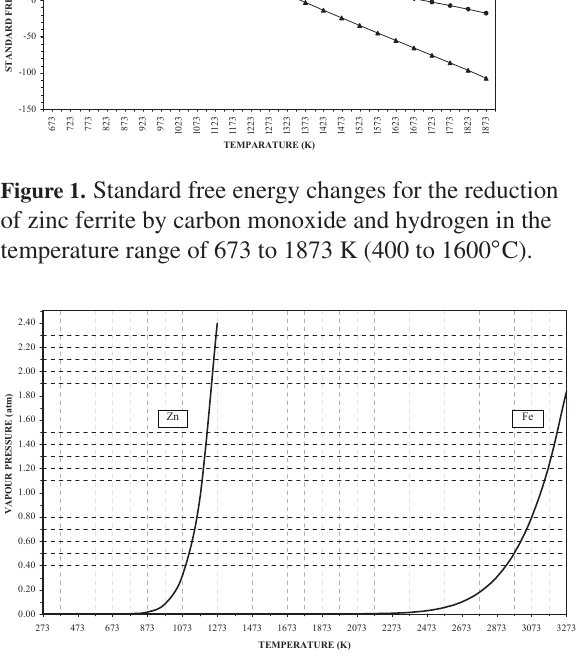
temperature of 973 K (700 ı C) or higher, metallic zinc in the form of zinc vapor and solid iron products can be obtained by the reduction of zinc ferrite with molecular hydrogen while the partial pressure of hydrogen is maintained very